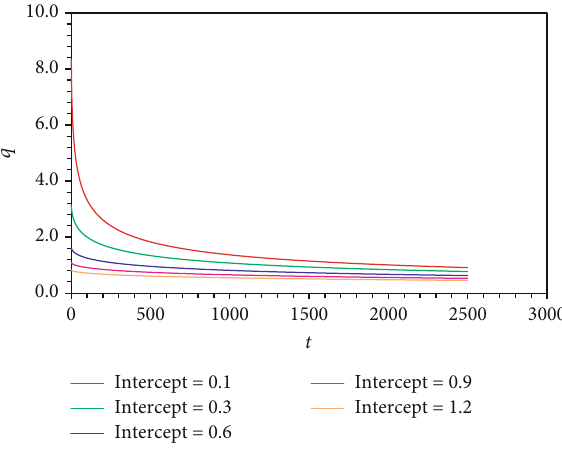
Figure 16: Rate/time curve with varied intercept and same